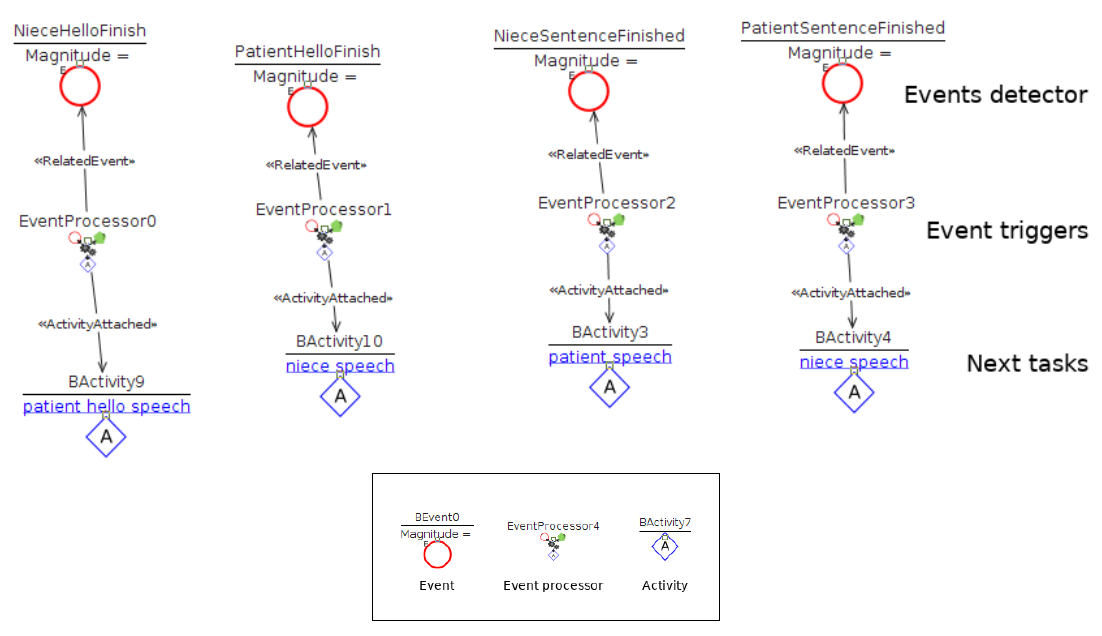
Figure 5. Representing the speech